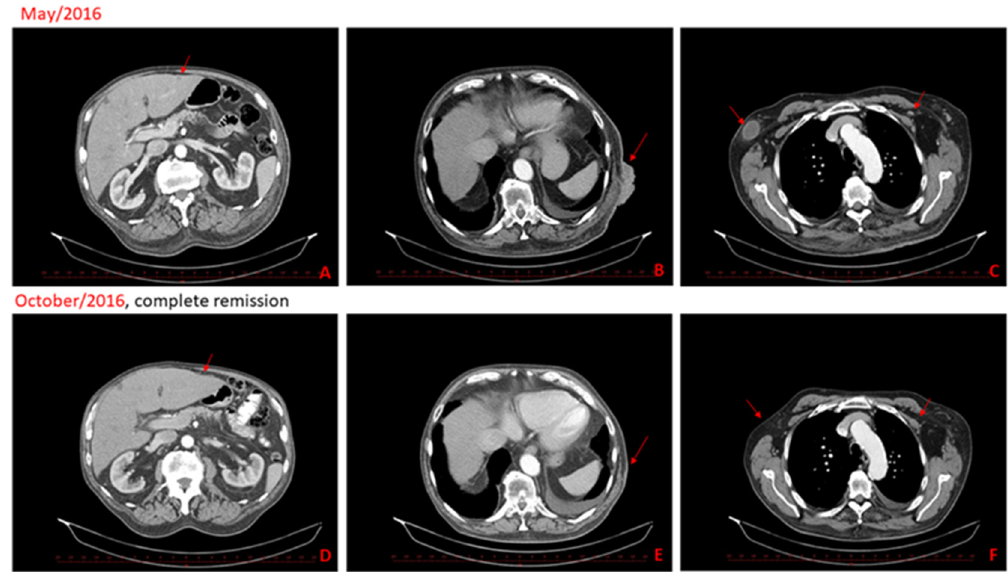
Figure 2. CT scans from May 2016 show progressive disease, new liver metastasis ( A ), skin and subcutaneous metastasis ( B ), left subclavicular node metastasis and right node axillary metastasis ( C ). CT scans in the second-line show complete remission of the metastatic disease, two months after cryotherapy and half a year after the last dose of ipilimumab ( D – F ).